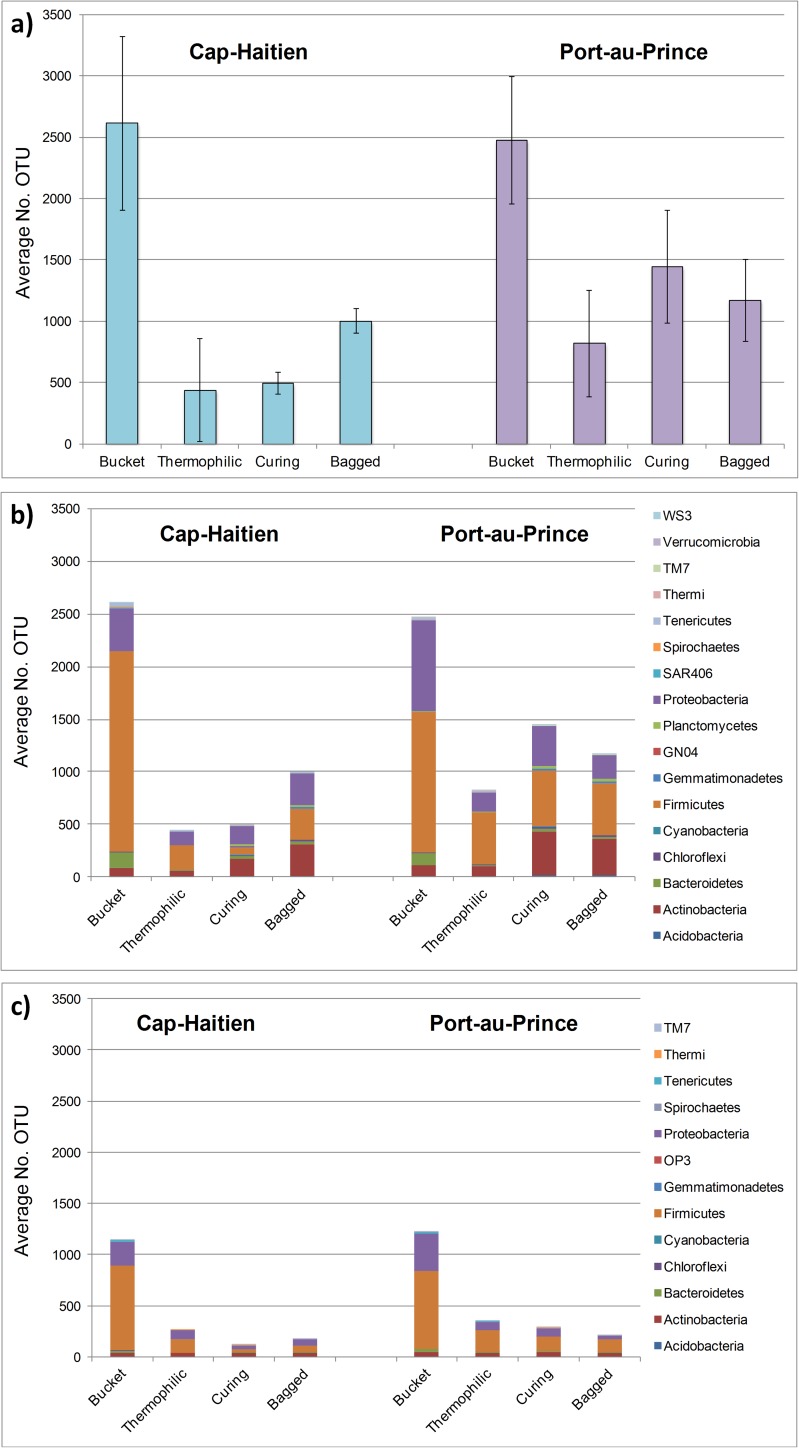
OTU relative richness calculated at each stage of a thermophilic composting process at two locations: Cap-Haitien and Port-au-Prince, Haiti.a) average number of OTU per composting process stage, error bars indicate standard deviation; b) distribution of OTU within phyla containing at least five OTU (main dataset of 7531 OTU); c) distribution of OTU within phyla comprising the 1768 OTU defined as human gut associated for this dataset (present in at least half the Bucket samples). Number of samples included per location: Bucket (n = 12), Thermophilic (n = 9 in Cap-Haitian, n = 7 in Port-au-Prince), Curing (n = 3), and Bagged (n = 3).